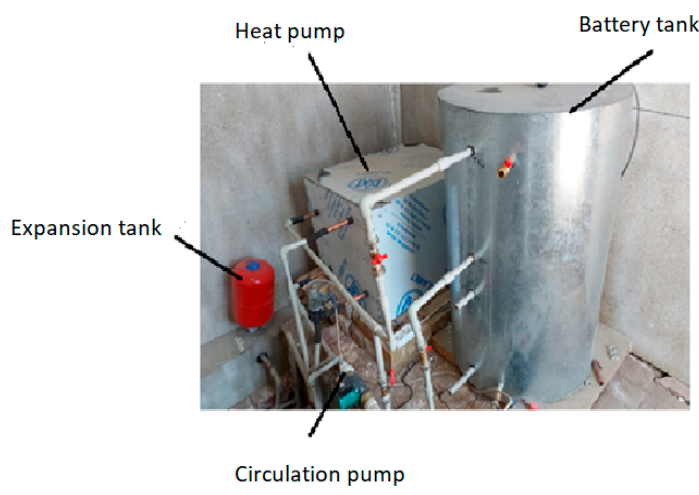
Figure 4. Industrial design and general view of a two-circuit solar installation.